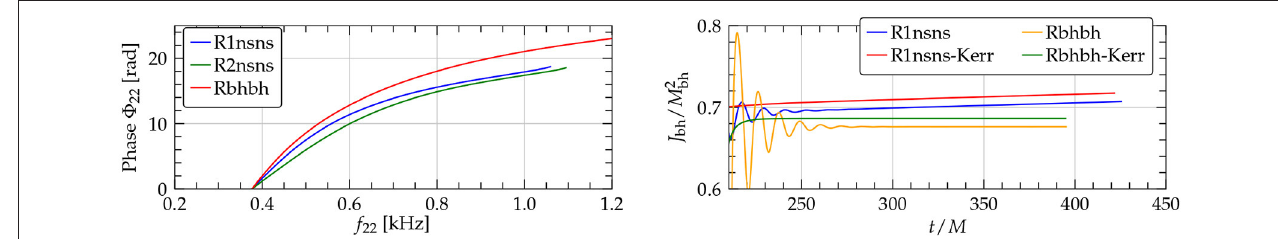
FIGURE 5 | (Left) GW phase vs. frequency for the NSNS binary using two resolutions (R1nsns,R2nsnsn) and a BHBH binary having the same gravitational mass. (Right) Dimensionless spin of the remnant BH for the NSNS (R1nsnsn) and the BHBH (Rbhbh) binary. Also shown is the dimensionless spin as computed from the Kerr formula for the two systems (from Tsokaros et al.,